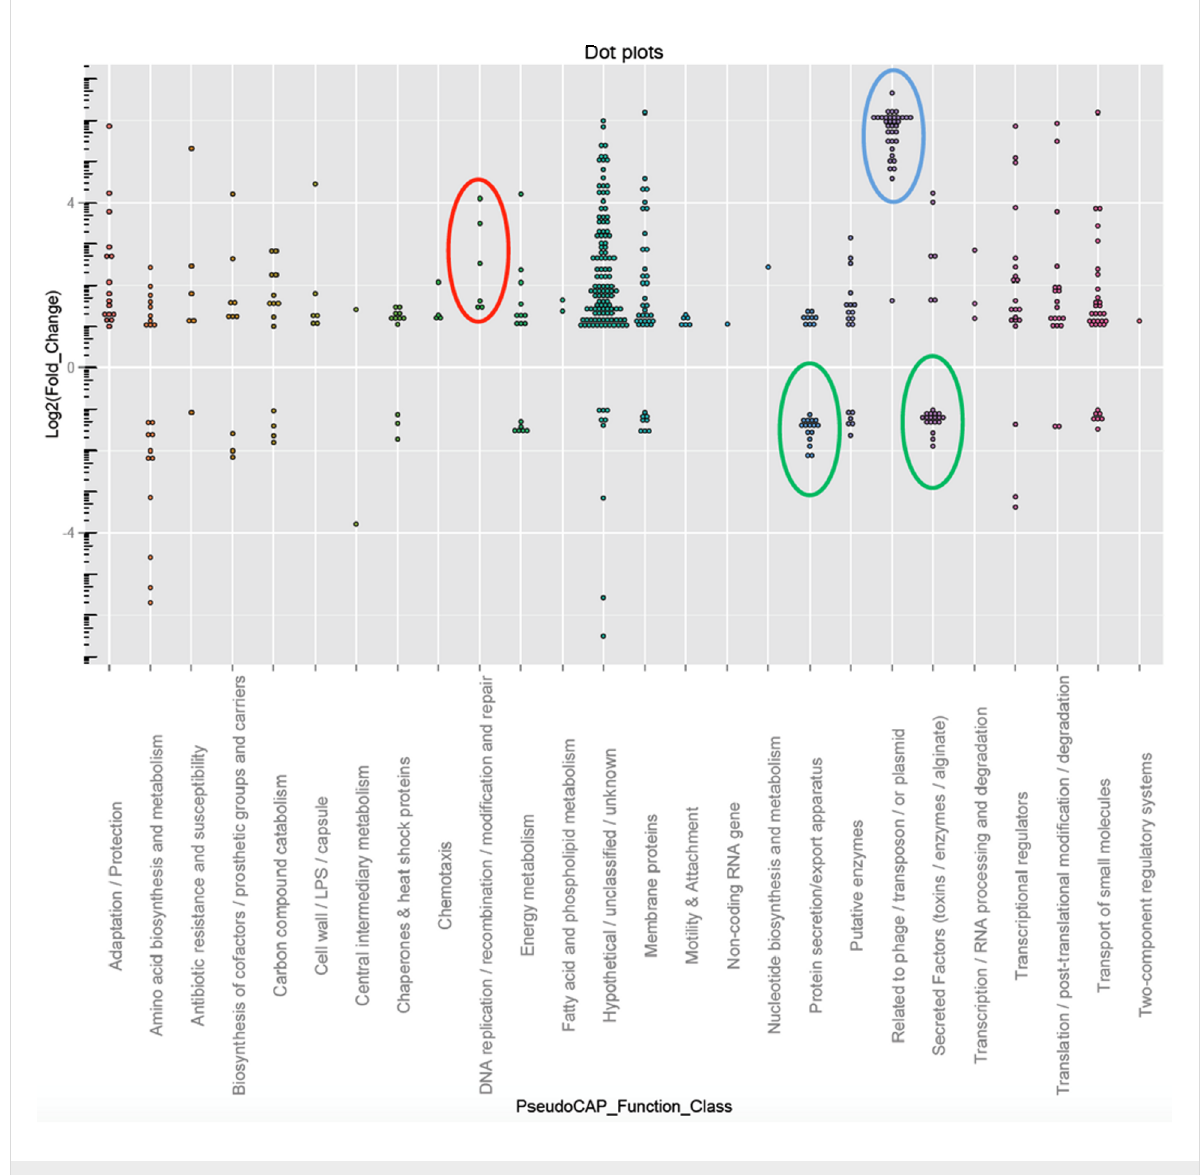
Figure 3: Function enrichment of differentially expressed genes from the transcriptomic analysis. A dot-lot figure was generated using ggplot2 the package of R. Red circle highlights the genes involved in DNA replication and repair; blue circle highlights the genes involved in pyocin synthesis; green circle highlights the genes involved in protein secretion